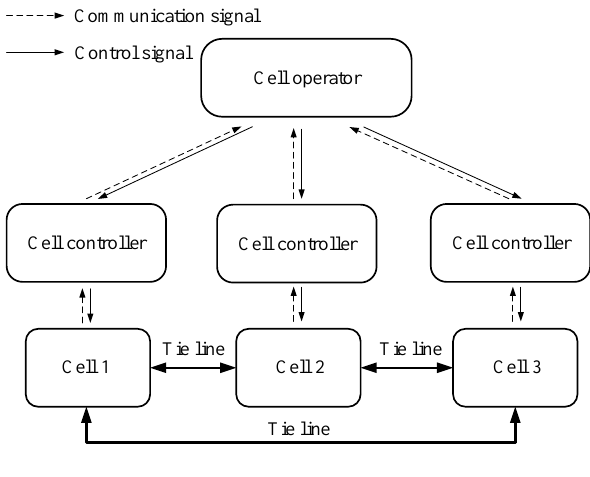
Figure 2. Control system